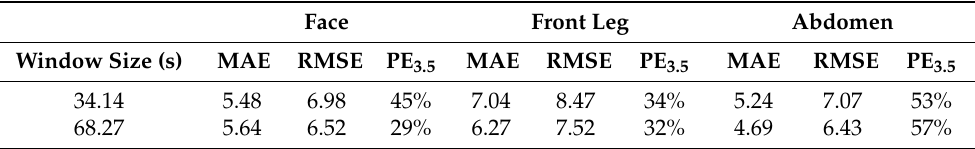
Table 3. Evaluation results of different regions of interest (ROIs) of the same size on the resting pig presented as mean absolute error (MAE), root mean square error (RMSE) and percentage of HR error below 3.5 beats per minute when compared to the gold standard.